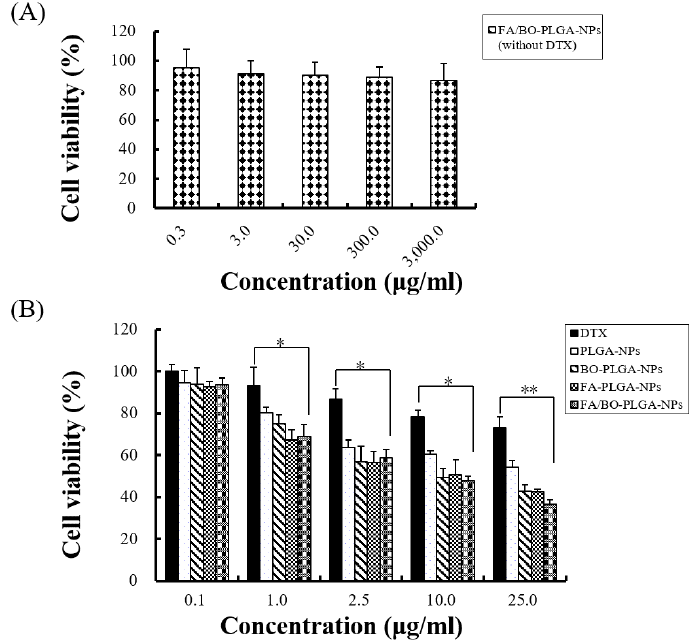
Figure 5. Cell cytotoxicity assay of different nanoparticles was evaluated by MTT assay. ( A ): empty